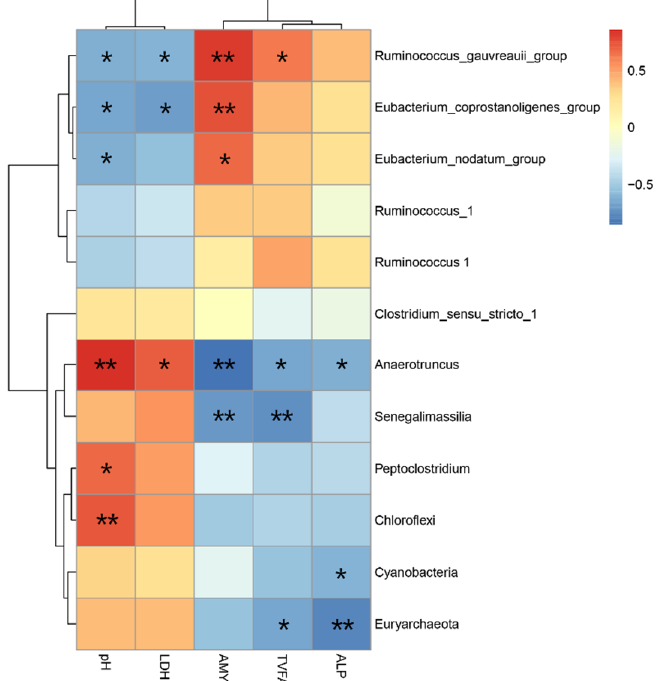
Figure 4. Correlation analysis among the ileal pH, LDH (lactate dehydrogenase), AMY (amylase), TVFA (total volatile fatty acids) and ALP (alkaline phosphatase) concentration and twelve associated species bacteria of difference at the level of genus are shown. Cells are colored based on Pearson’s correlation coefficient between the metabolites and associated bacteria of difference in the intestine (red indicates negative correlation, and blue indicates positive correlation, * and ** respectively indicate p < 0.05 and p < 0.01).